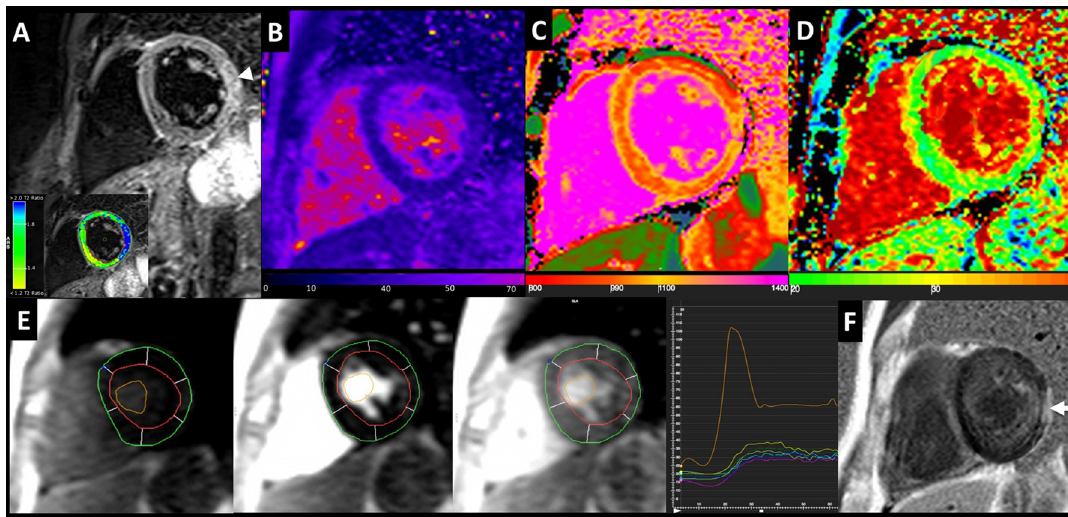
Fig 2. 40 years-old male SSc patient (dcSSc pattern) with 13-years history of SSc disease duration. STIR-T2w image shows an area of myocardial edema on left ventricular lateral wall (arrow), emphasized by the analysis of T2 myocardial-to-skeletal muscle signal intensity ratio (box below). Analysis of myocardial T2 (b.), nT1 (c.) and ECV (d.) maps showed T2 value of 51 ± 2.5 ms, a mild diffuse increase of global myocardial nT1 (1050 ± 24 ms) and a slight increase of ECV (33 ± 3.4%). Perfusion images (e.) before, during and after the passage of contrast bolus with relative signal intensity-time curves at different time-points of the myocardial segments and ventricular cavity. LGE image (f.) show a mid-subepicardial enhancement on the lateral wall (arrow). https://doi.org/10.1371/journal.pone.0244282.g002 nT1, T2 and ECV values SSc patients had significant higher native myocardial nT1 and T2 values compared to controls (SSc vs. controls: nT1 = 1029.2 ± 32.1 ms vs. 984.9 ± 17.8 ms, p < 0.01; T2 = 50.1 ± 2.8 ms vs. 47 ± 1.5 ms, p < 0.01; Fig 3A and 3B), also when considering the two distinct patterns of the disease (dcSSc/lcSSc Vs. controls, p < 0.01, Table 3). SSc patients showed a significantly higher ECV (30.1 ± 4.3%) than controls (26.7 ± 2.4%, p = .049, Fig 3C), whereas there were no differences in myocardial ECV between patients with and without LGE. A slight non-significant increase of nT1 and T2 values was noted in lcSSc subgroup compared to dcSSc. Ninety-fifth percentile values of nT1, T2 and ECV measure- ments in healthy controls were respectively 1010ms, 49.7ms and 29.8%.